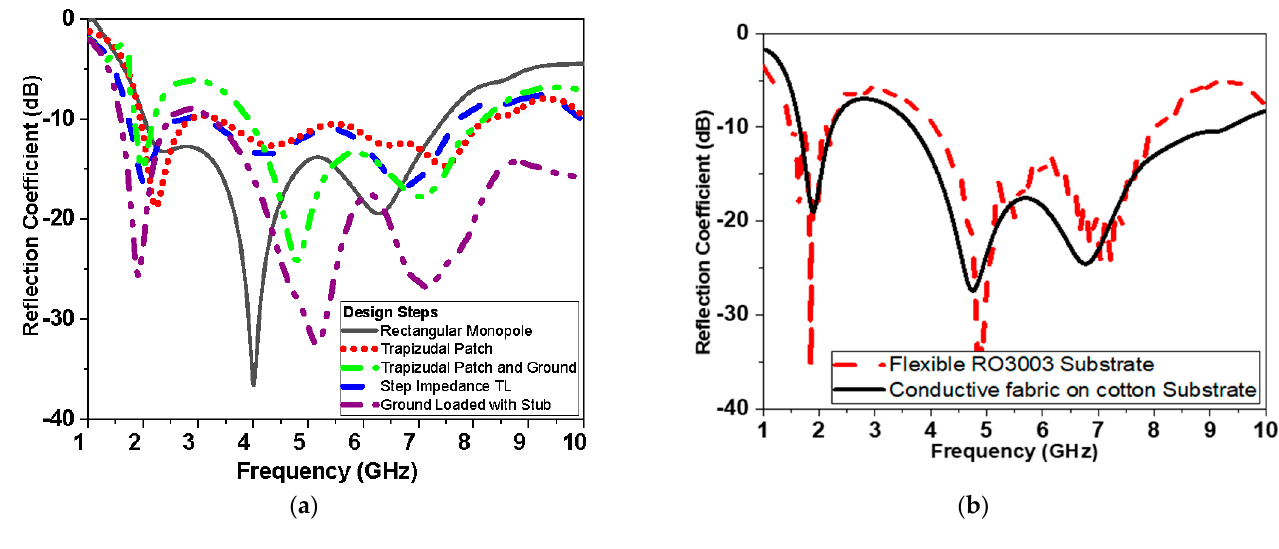
Figure 9. Simulated reflection coefficient in dB versus frequency: ( a ) different stages of monopole antenna design shown in Figure 1; ( b ) proposed monopole using flexible Roger 3003 and conductive textile fabric.